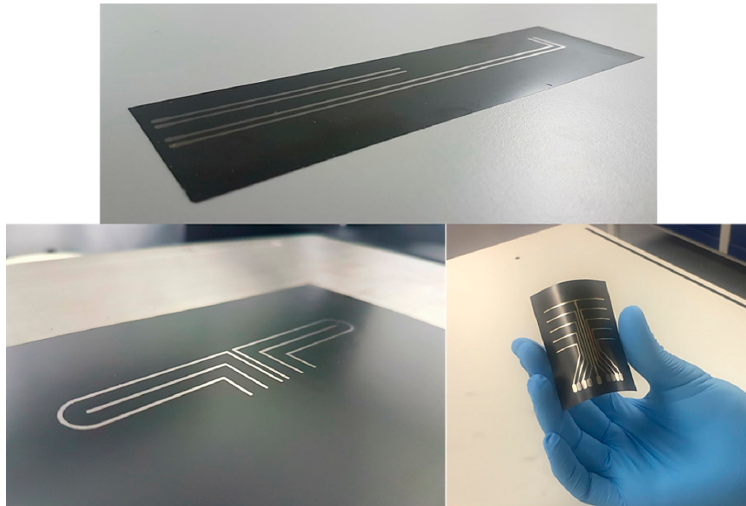
Figure 4. Inkjet printer and three network printed patterns.